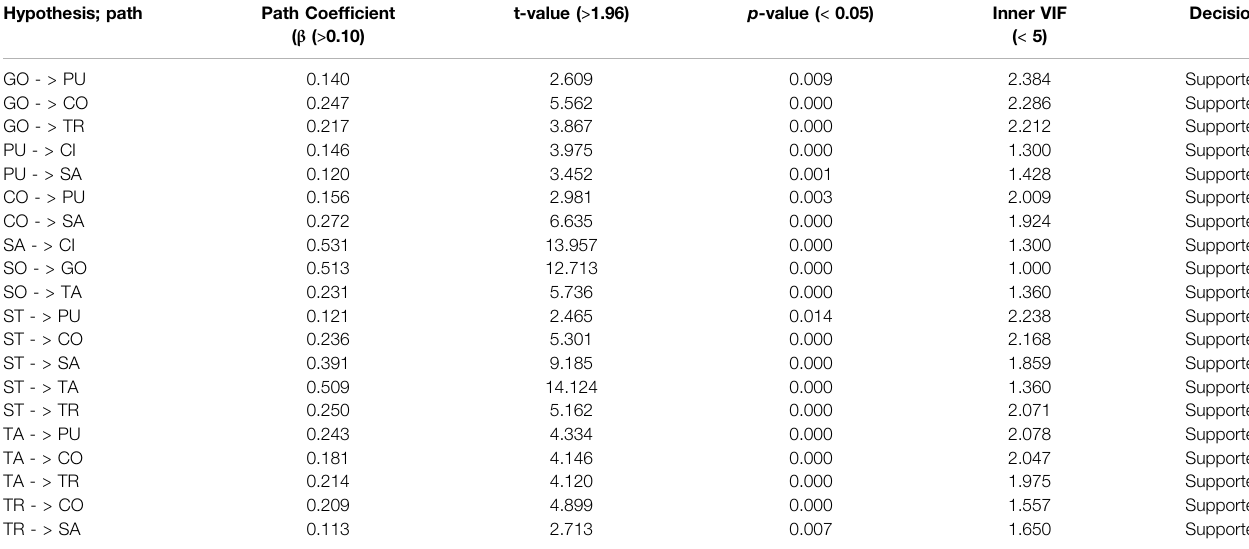
TABLE 6 | Structural model